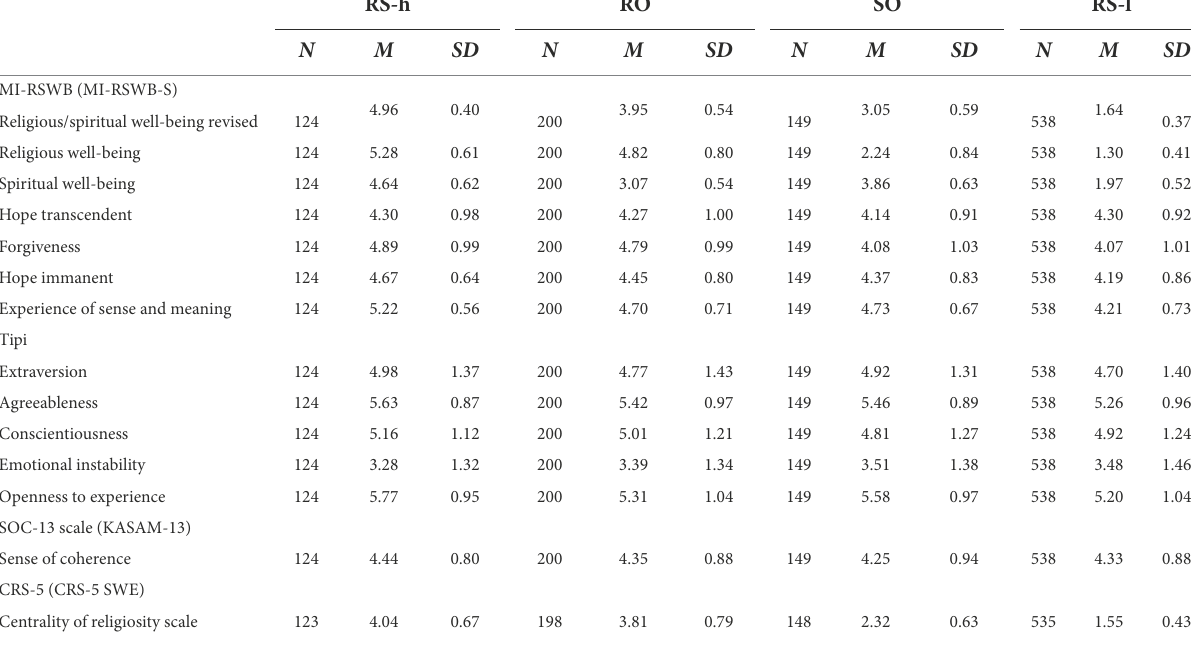
TABLE 3 Descriptive statistics for the MI-RSWB (subscales and joint factor), TIPI, SOC-13 scale, and